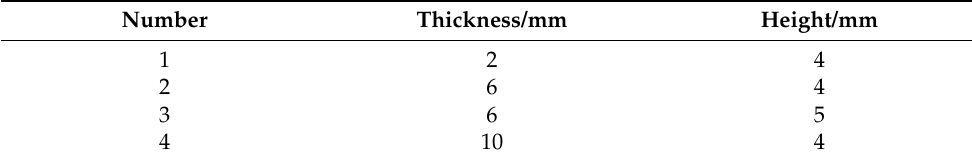
Table 3. Structural parameters.